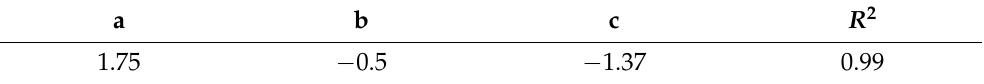
Figure 5. Collapsed profile of the normalized maximum wake velocity deficit for the test cases as a function of the new streamwise scaling. The dashed line corresponds to the fitted function. Table 2. Fitting parameters of Equation (3); R 2 corresponds to the fit correlation